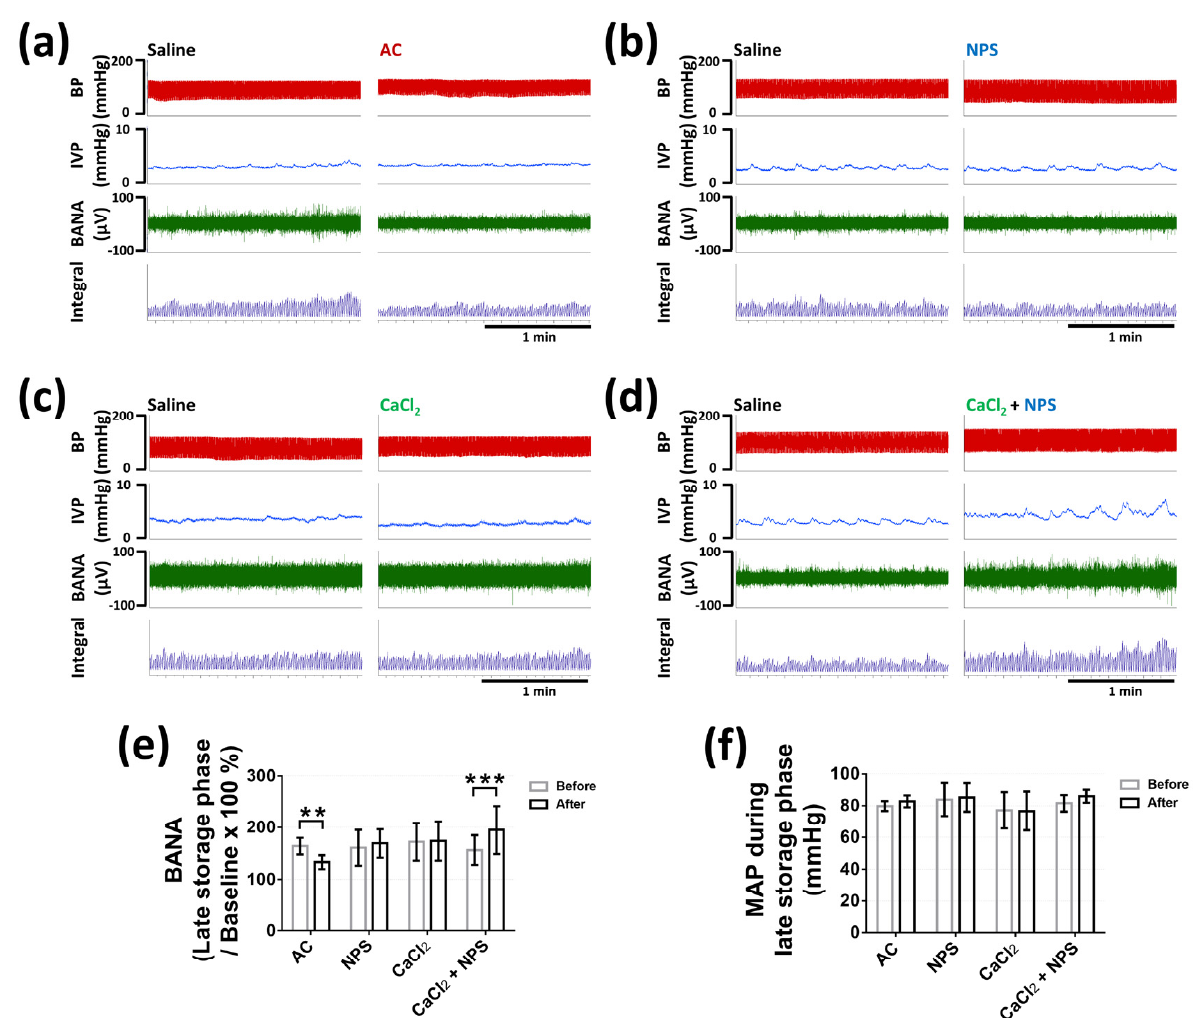
Figure 6. The effects of CaSR agonist (AC), CaSR antagonist (NPS), CaCl 2 , and CaCl 2 containing NPS on bladder afferent nerve activity (BANA). The effects of intravesical administrations of 1 mM AC ( a ), 1 mM NPS ( b ), 20 mM CaCl 2 ( c ), and 20 mM CaCl 2 containing 1 mM NPS (CaCl 2 and NPS) ( d ) on BANA during late storage phase. The statistical analysis of the change of BANA during late storage phase ( e ), and the mean arterial pressure (MAP) during late storage phase ( f ) before (saline) and after different treatments in each group (Two-tailed paired Student’s t -test, n = 6 for each group; ** p < 0.01, *** p < 0.001, as compared with saline treatment in each group).